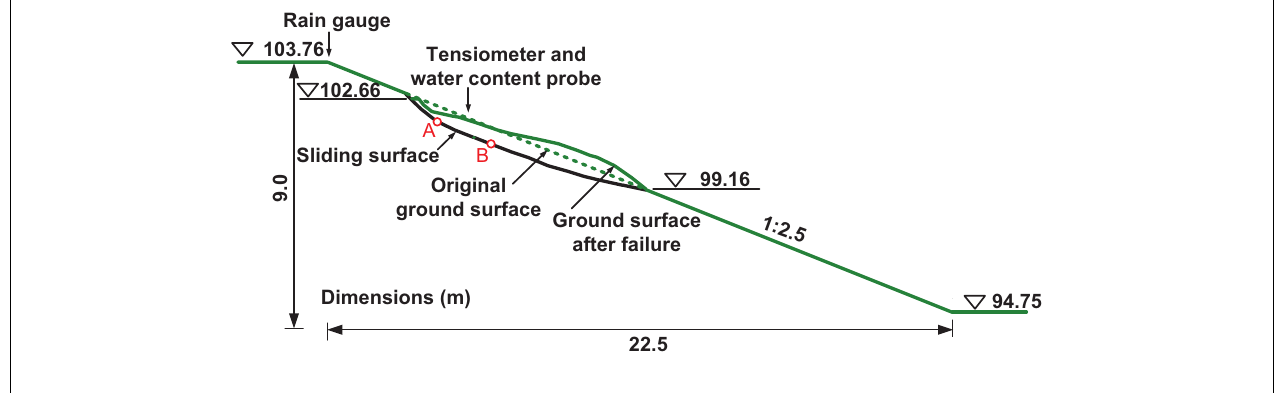
FIGURE 1 | Cross section of studied slope from Zhang et al.